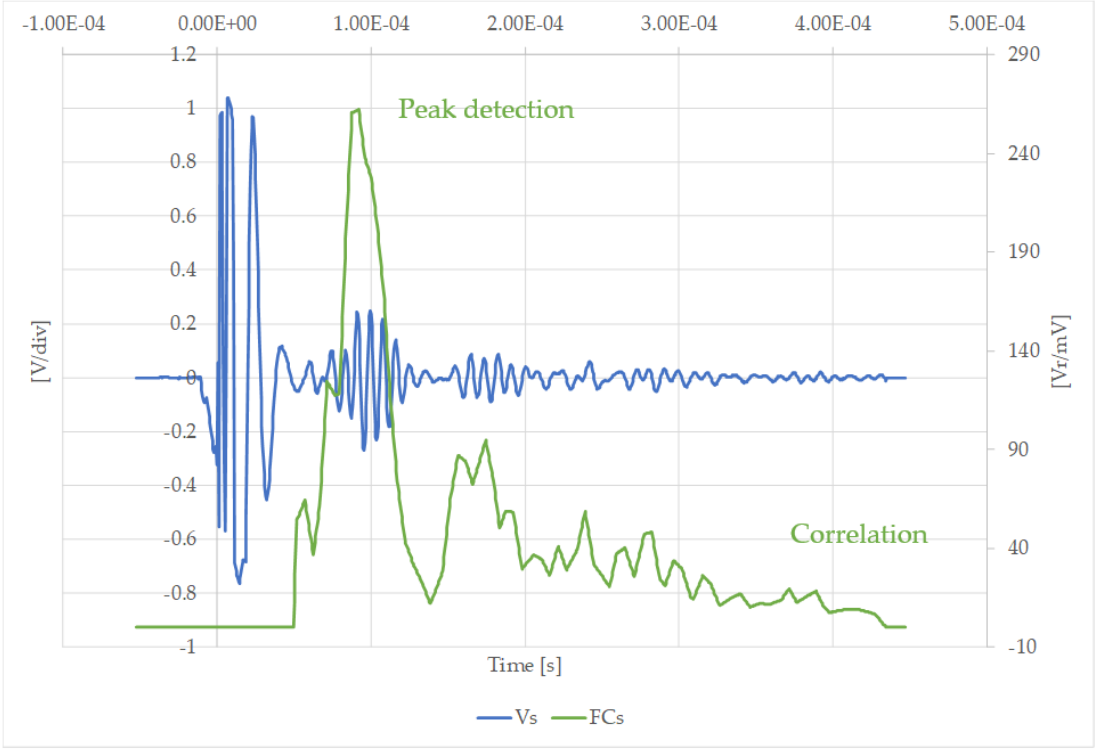
Figure 17. Measured, Vs [V / div], and filtered signal, FCs [Vr / mV], after using the correlation filter in the case of a partial silicone blockage at position A.